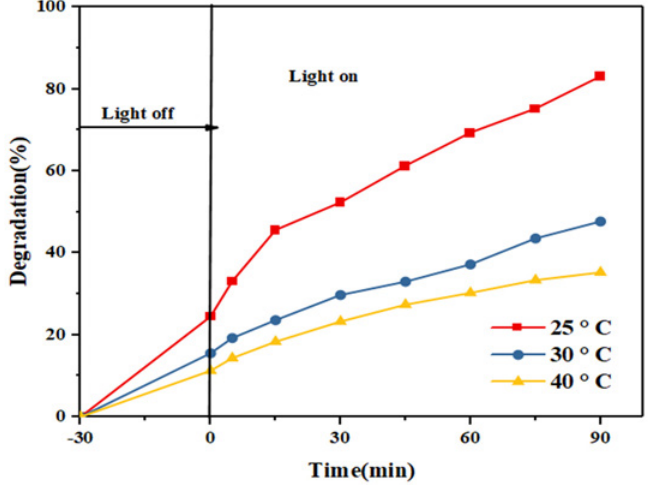
Fig. 8. Effect of temperature on photocatalytic degradation of albumin